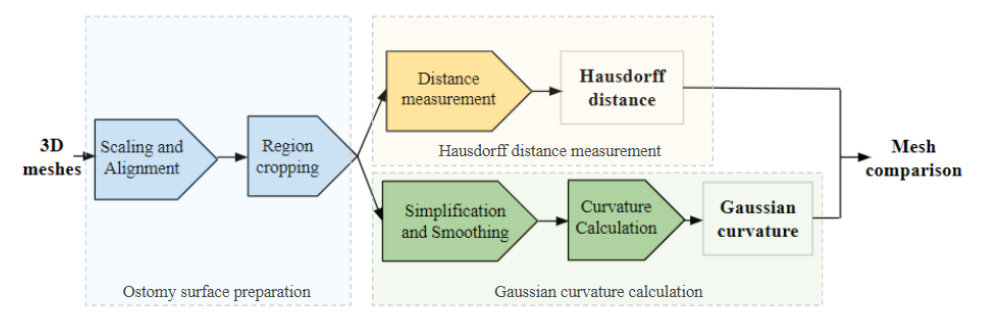
Figure 15. Diagram of mesh processing